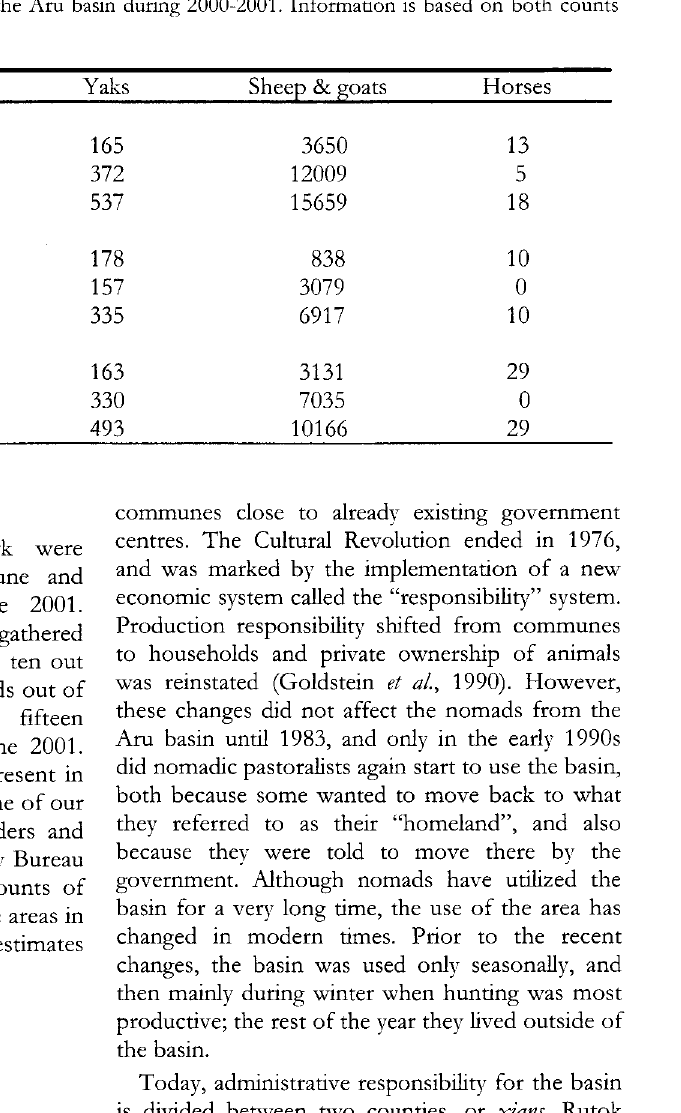
Table 1. Numbers of people and livestock in the Aru basin during 2000-2001. Information is based on both counts and interviews 2